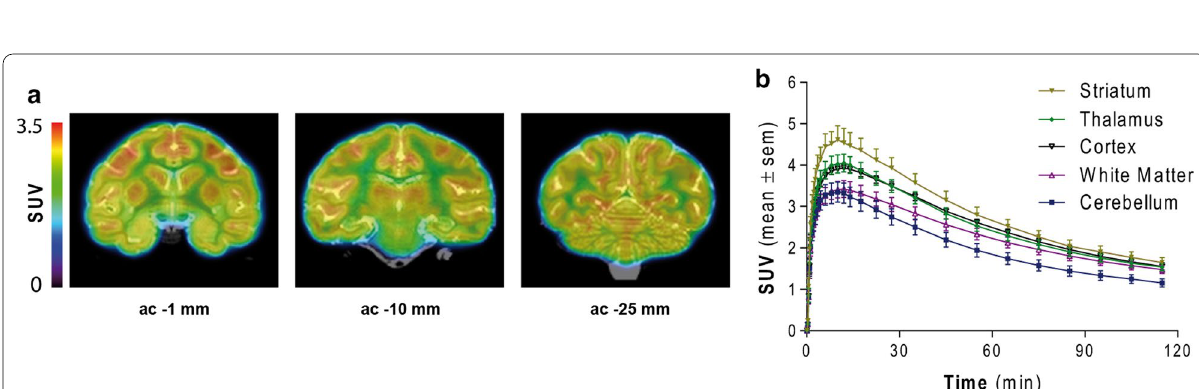
Fig. 2 a Representative 60–120 min summed coronal PET images at ac -1 mm, ac – 10 mm and ac -25 mm coregistered to T 2 -weighted MR images. b Average ( SEM) TAC in striatum, thalamus, cortex, white matter and ±